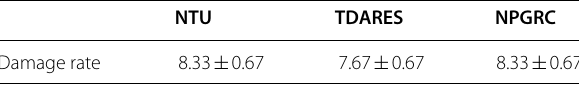
Table 4 Injury rating of three accessions of the Taichung Native 1 (TN1) rice variety infested by N.